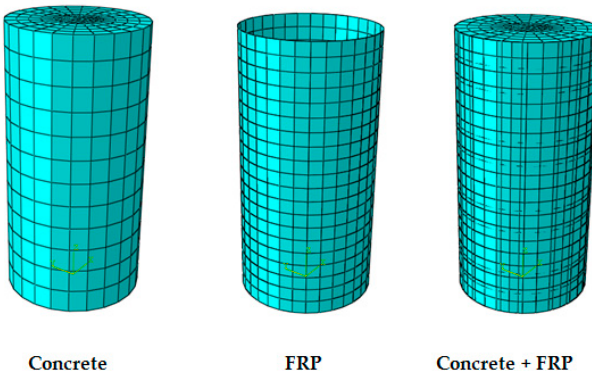
Figure 4. Mesh of the FRP concrete column model.